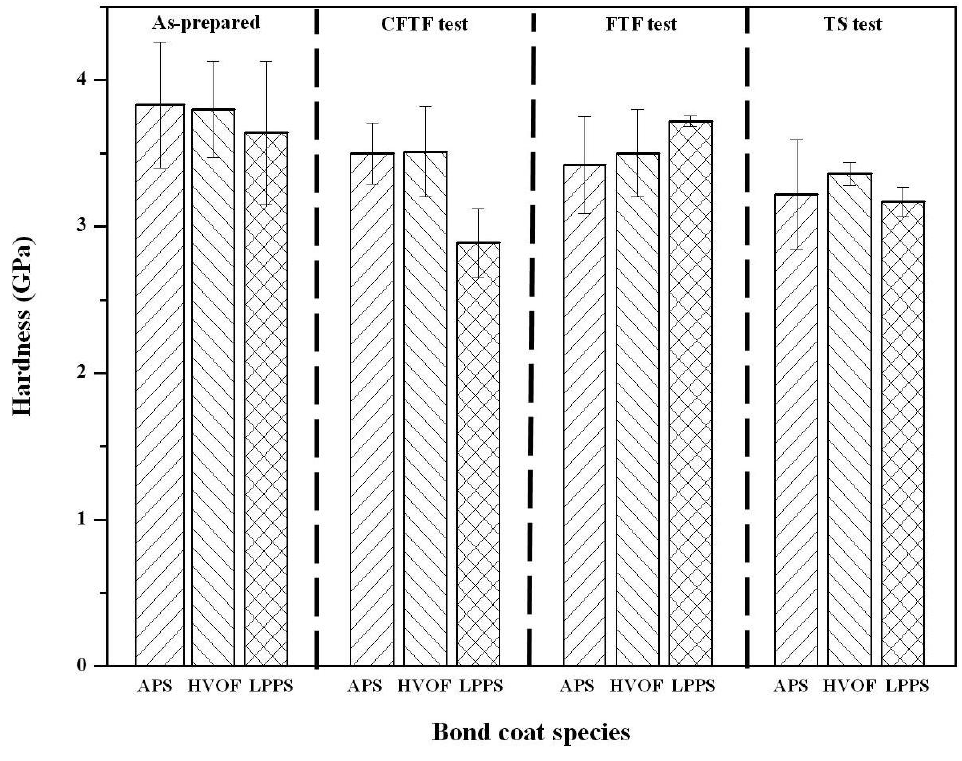
Figure 11. Hardness values of bond coats before and after cyclic thermal exposure. Indentation for hardness was conducted on the sectional plane at 3